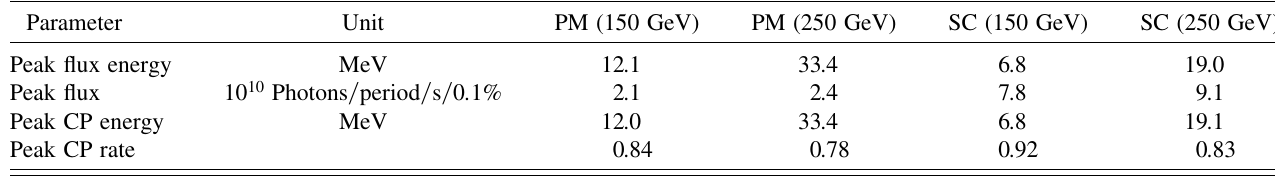
TABLE IV. Peak flux and circular polarization values for SC and PM undulators.